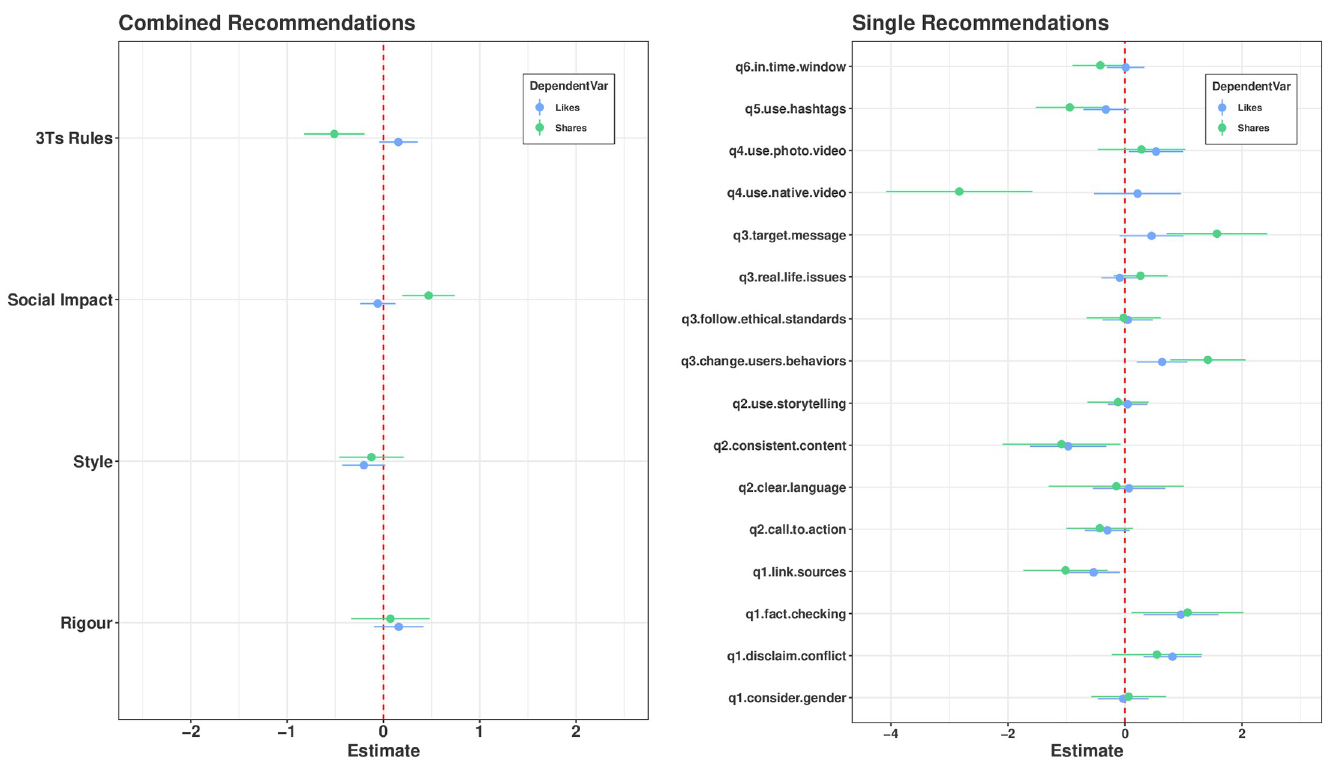
Fig 6. Point estimates and 95% confidence interval of negative-binomial regressions coefficients (Facebook). Left Panel: Coefficient estimates obtained by regressing likes (in blue) and shares (in green) on the number of recommendations adopted for each leading principle. Right panel: Coefficient estimates obtained by regressing likes and shares on each